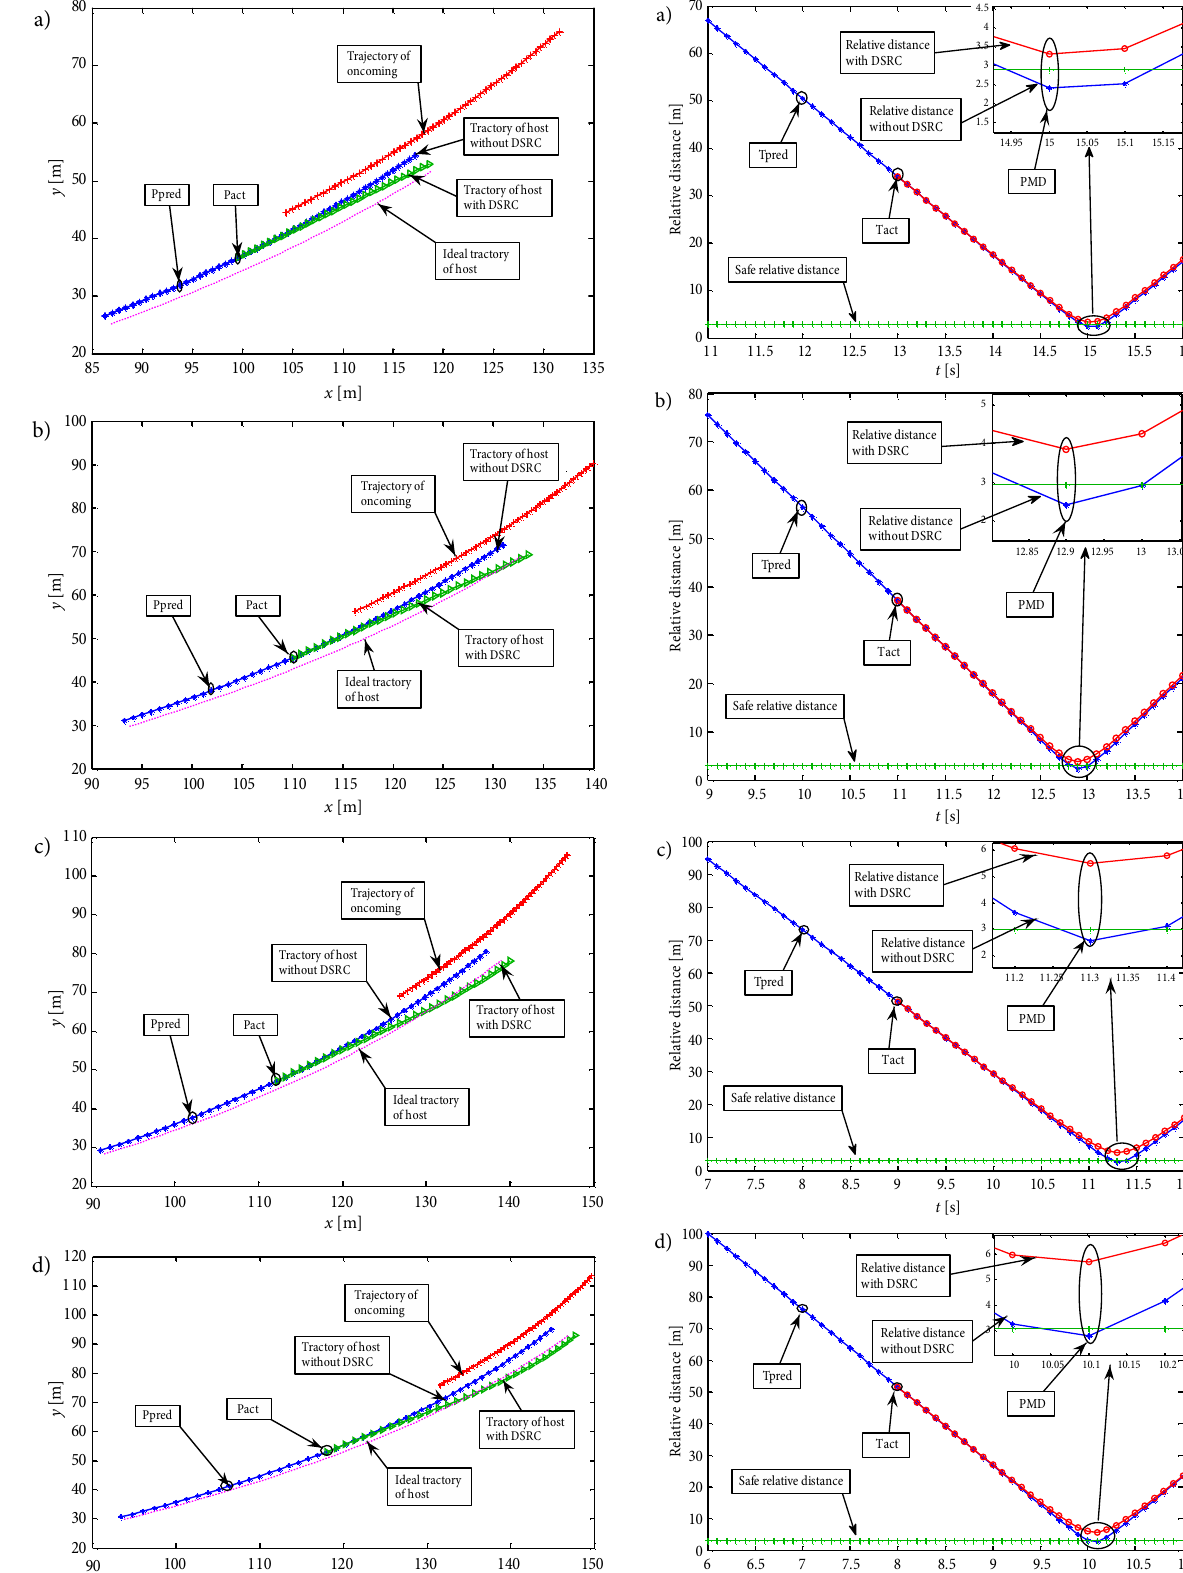
Fig. 7. Change in relative distance between the host and the oncoming vehicle over time: a – v host = 30 km/h; b – v host = 40 km/h; c – v host = 50 km/h; d – v host = 60